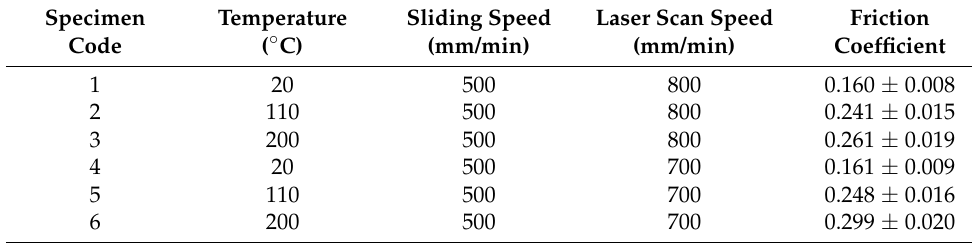
Table 6. Friction coefficient at different